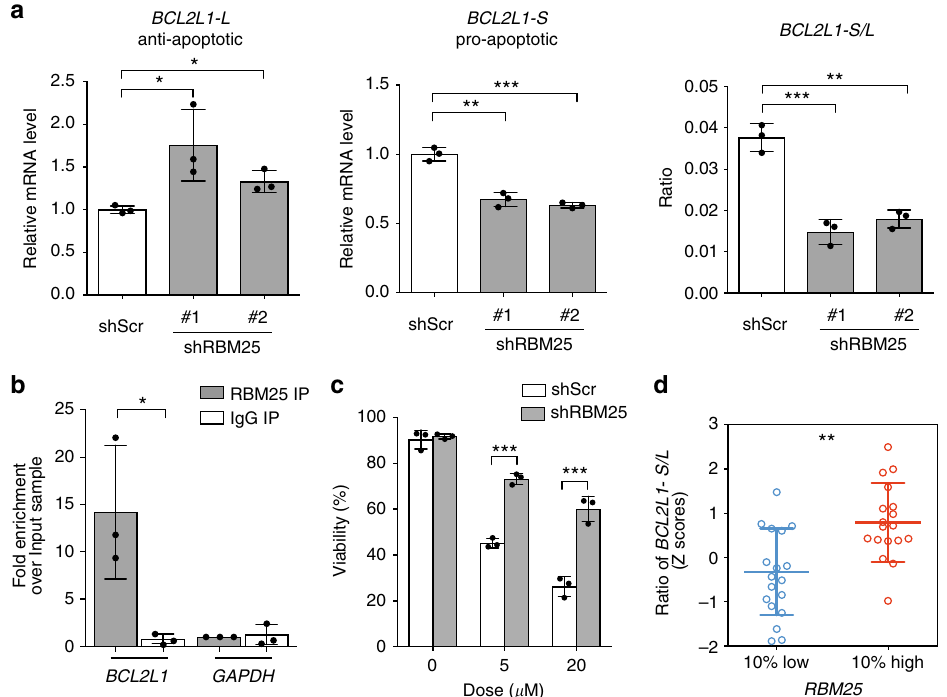
Fig. 5 RBM25 knockdown alters the abundance of different BCL2L1 isoforms. a qPCR showing altered expression of BCL2L1 - L (left), BCL2L1 - S (middle), and BCL2L1 - L to BCL2L1 - S ratios (right) in U937 cells before and after RBM25 KD b RIP assay demonstrating direct interaction between RBM25 and endogenous BCL2L1 transcripts in U937 cells using GAPDH as a negative control. c The effect of ABT-263 on cell viability before and after RBM25 KD. d Correlation between RBM25 levels and BCL2L1 - L to BCL2L1 - S ratios in AML patients (TCGA data 21 ). Bar plots in ( a ) − ( c ) represent the mean ± s.d., n = 3. Data were subjected to an unpaired t test, and asterisks indicate the following: * P < 0.05; ** P < 0.01; *** P < 0.001. d The data were Z-score normalized and P values were calculated using the Mann − Whitney test ( n = 18), ** P < 0.01. Panels ( a )( c ) show representative results of ≥ 2 independent experiments. All replicates in ( a ) − ( c ) are biological